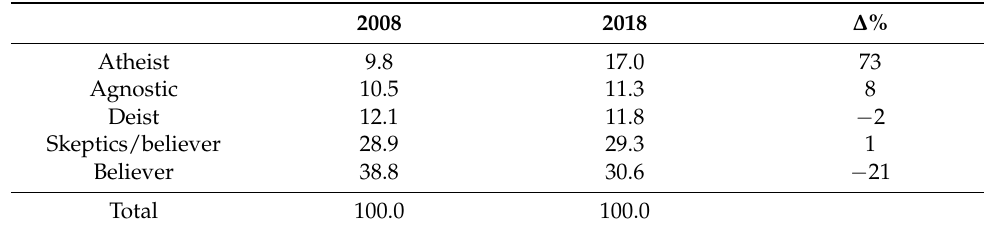
Table 2. Religious options in Spain between 2008 and